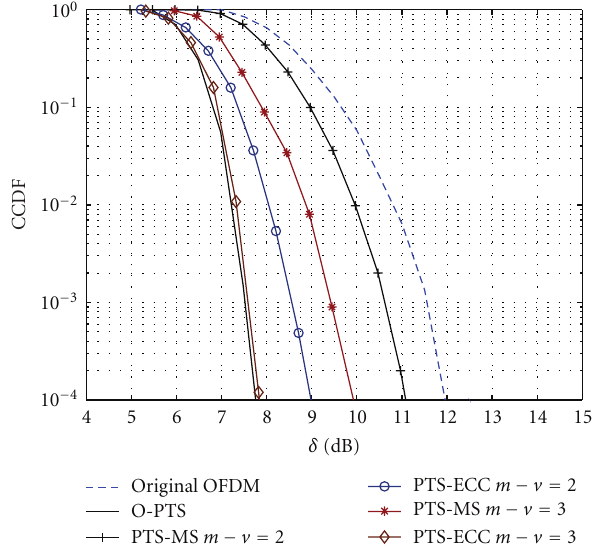
Figure 16: PAPR CCDF for PTS-ECC with 2 and 3 remaining stages, PTS-MS and O-PTS for N = 256 and P = 8.